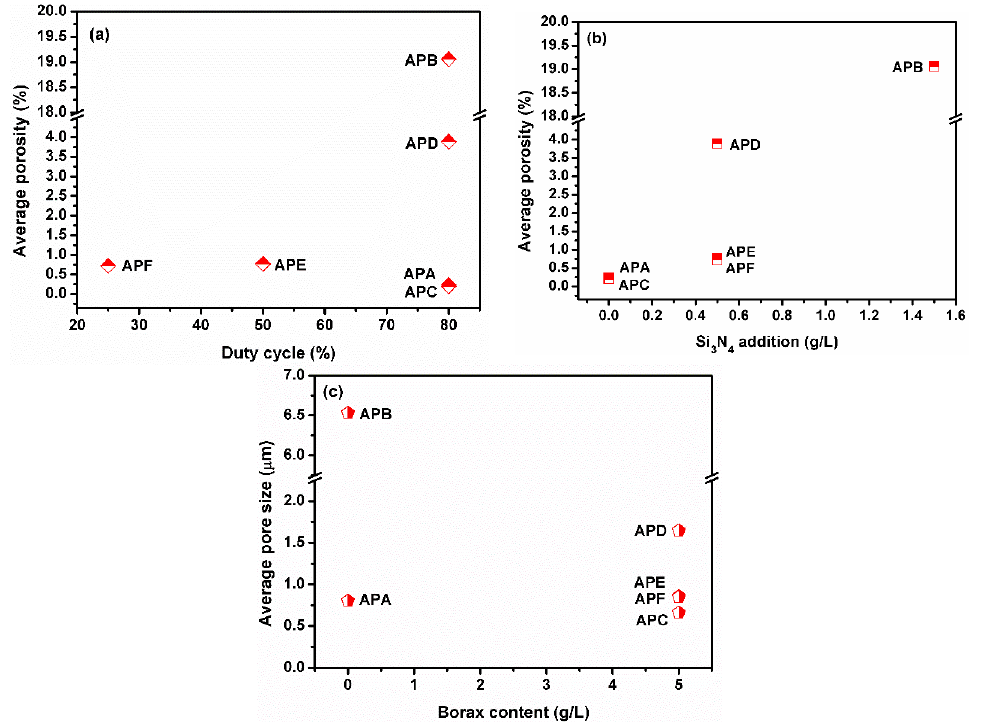
Figure 9. The relationships between porosity and ( a ) duty cycle, ( b ) Si 3 N 4 and ( c ) borax concentrations.